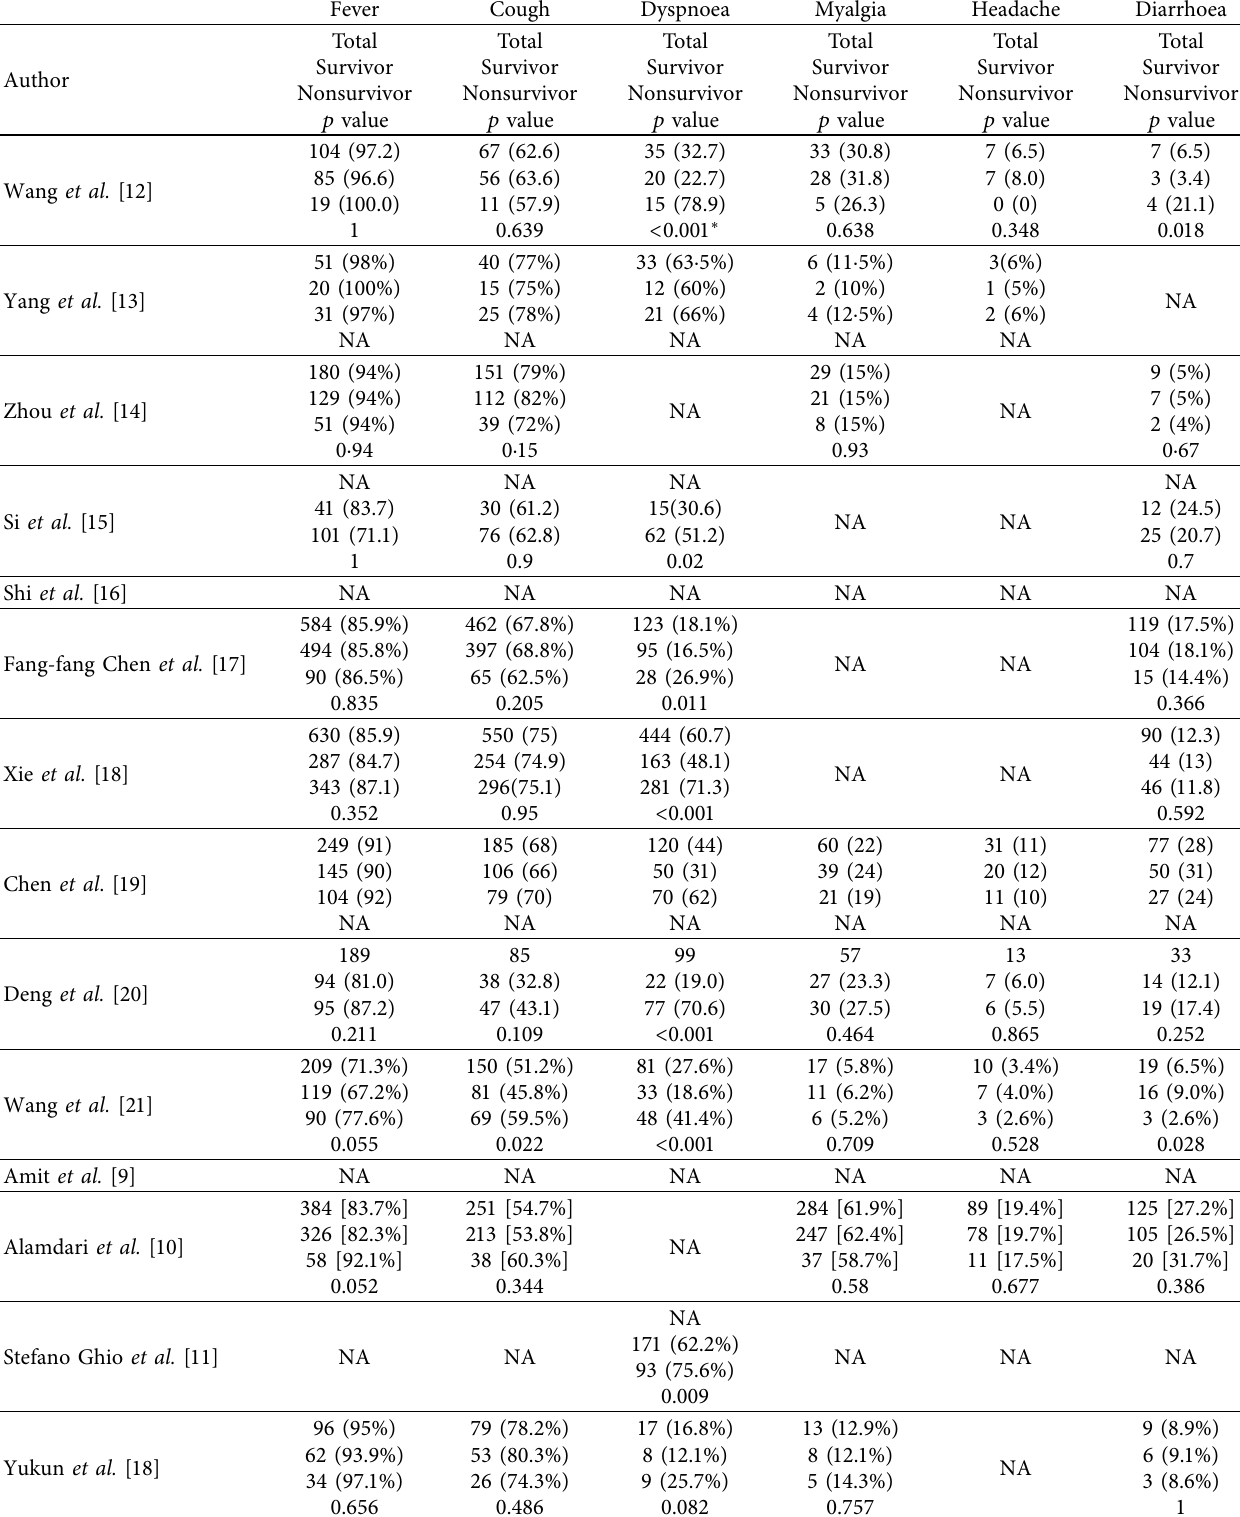
Table 3: Symptoms of the patients at the time of